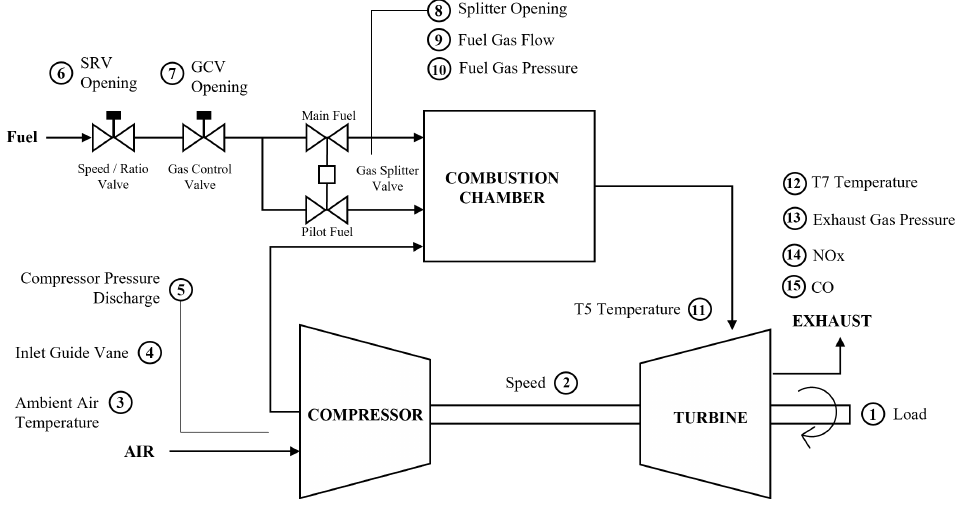
Figure 5. System flow diagram of the DLE gas